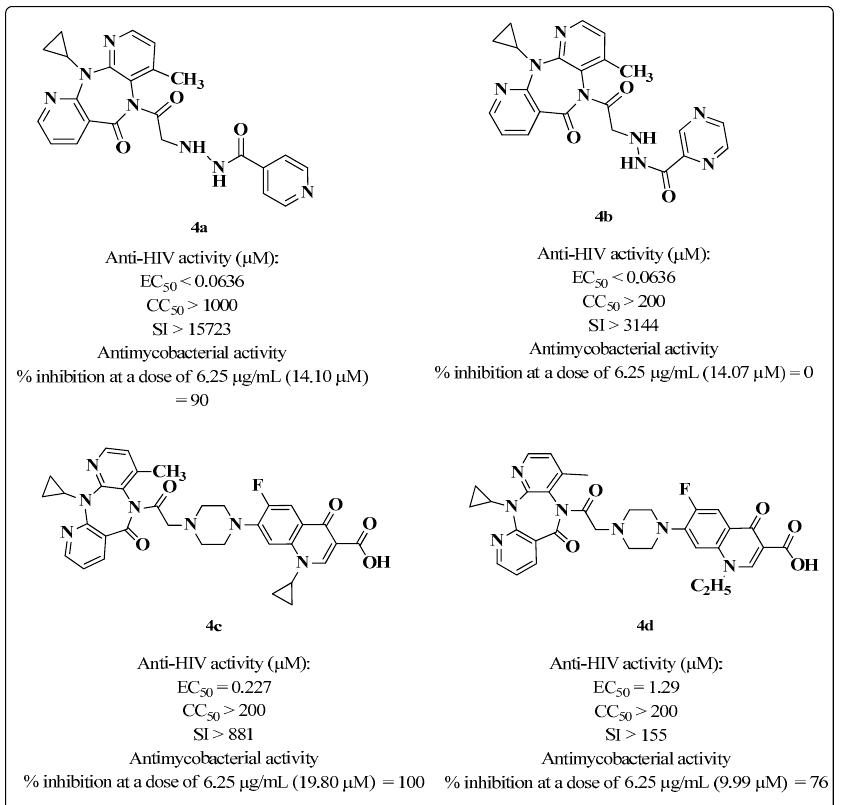
Figure 9. Anti-HIV (in CEM cells) and anti-MTB (in H37Rv cells) activity of the compounds synthe- sized by Sriram et al. in 2005 [81].